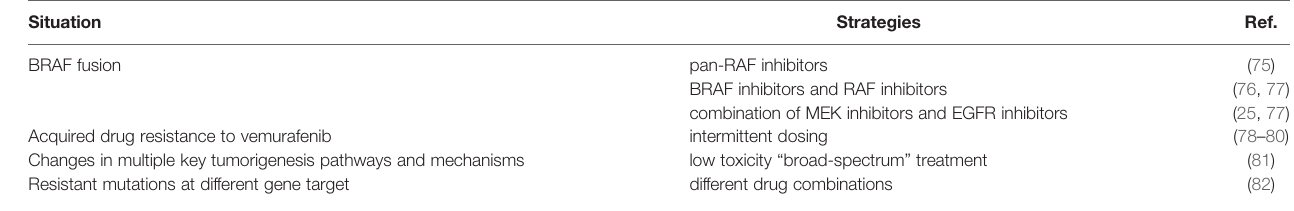
TABLE 1 | Strategies for resistance to BRAF inhibitors.